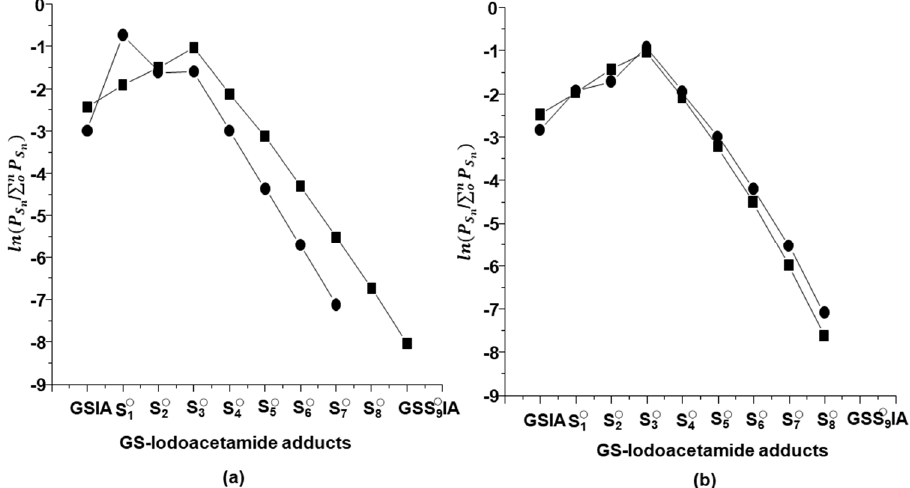
Figure 3. Logarithmic relative distribution of GSS n A adducts in ( a ) aerobic and ( b ) anaerobic reactions between GSNO and Na 2 S (1:1) with IA present at the beginning (filled circle) or added after 1 hr initiation (filled square) as calculated from the peak area of their respective SICs.